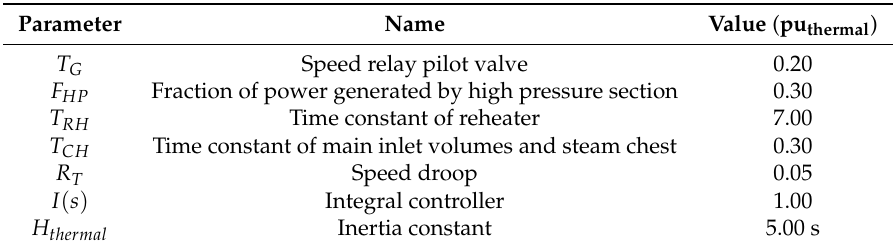
Figure 4. Conventional generation modeling. ( a ) thermal plant model; ( b ) hydro-power plant model. Table 1. Thermal power plant parameters